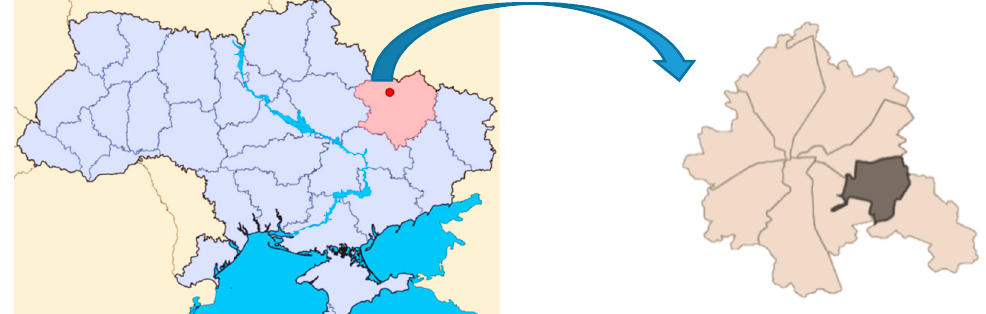
Figure 1. Location of research area (maps from open sources Google).